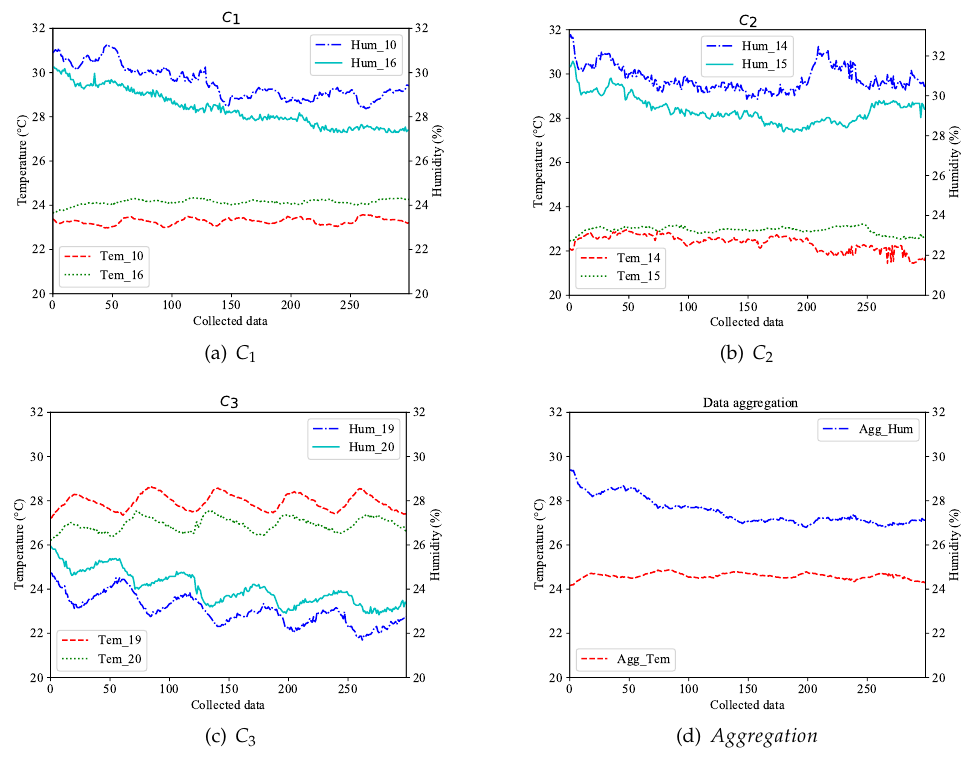
Figure 4. Comparative analysis for data